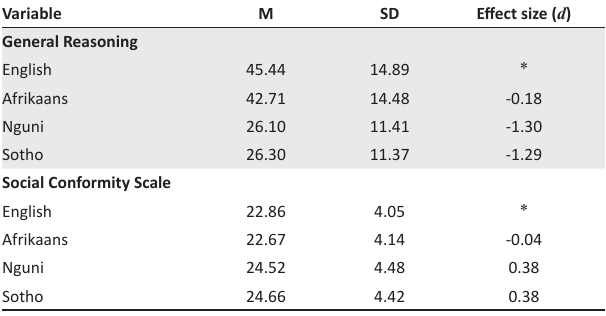
TABLE 1: Descriptive statistics for general reasoning and social conformity